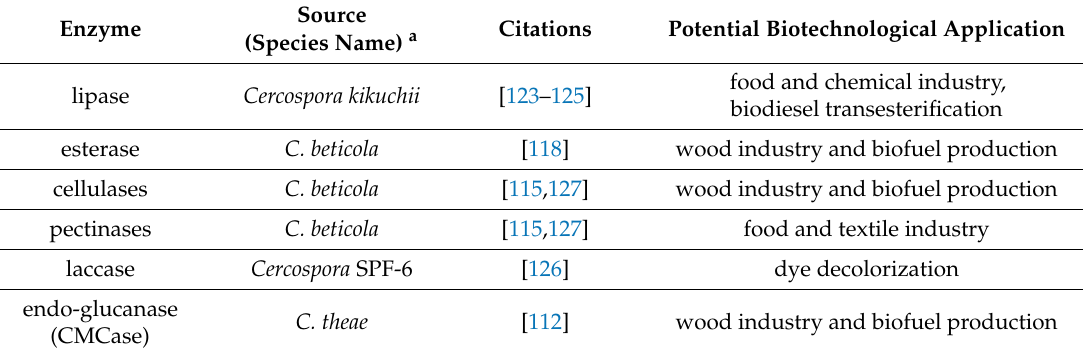
Table 1. Enzymes from cercosporoids and their potential biotechnological